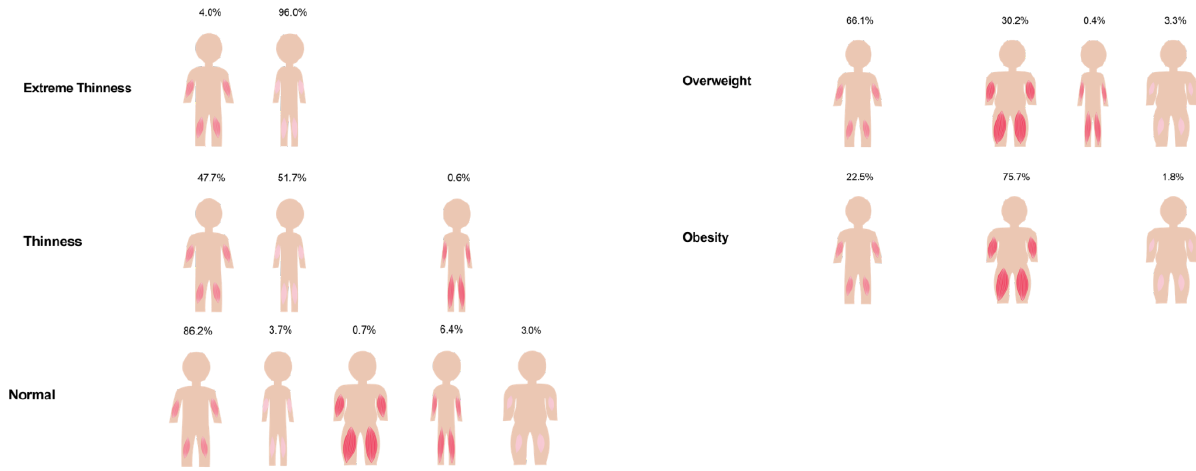
Abbreviations: FMI = fat mass index, ALMI = appendicular lean mass index, BMI = Body mass index, WHO = World Health Organisation. Figure 2. Prevalence of body composition groups in BMI categories. Figure shows the prevalence of the different body composition groups in BMI categories. The different body composition groups are represented by different figures. Vary-